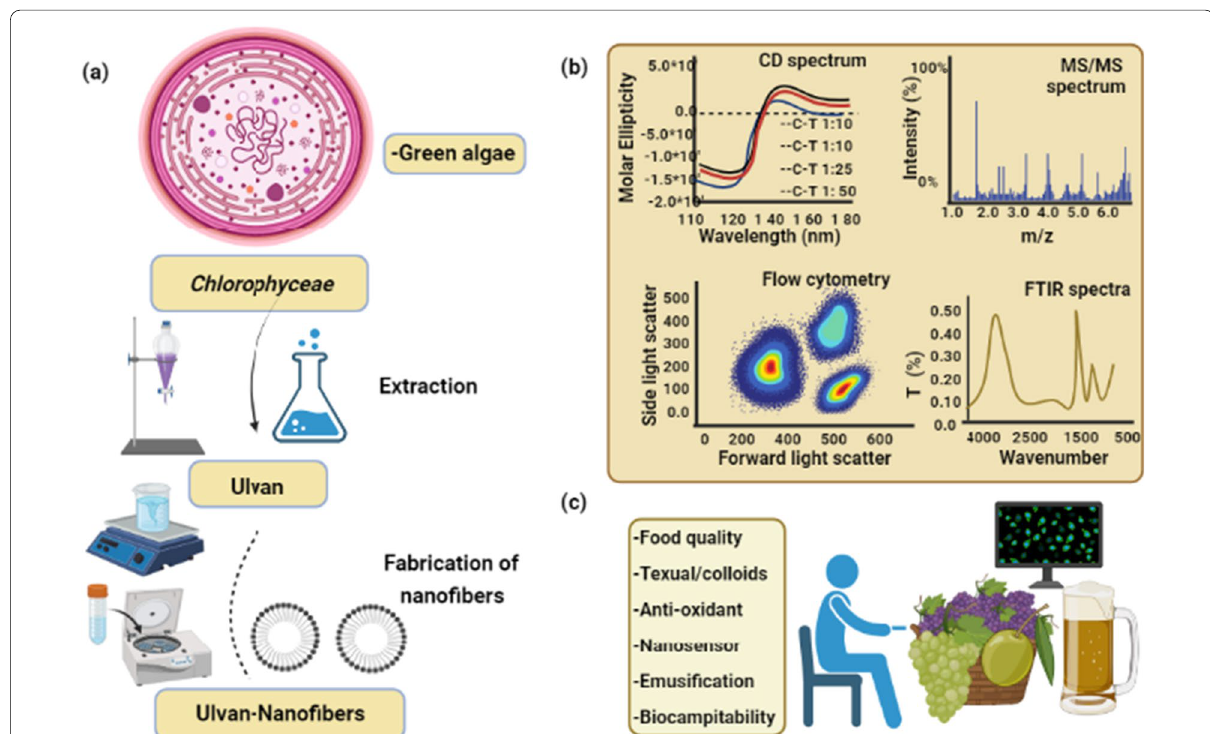
Fig. 4 a Extraction of ulvan from chlorophyceae marine green algae to make ulvan nanofibres, b characterization of ulvan nanofibres with different techniques, c and its application with various sectors